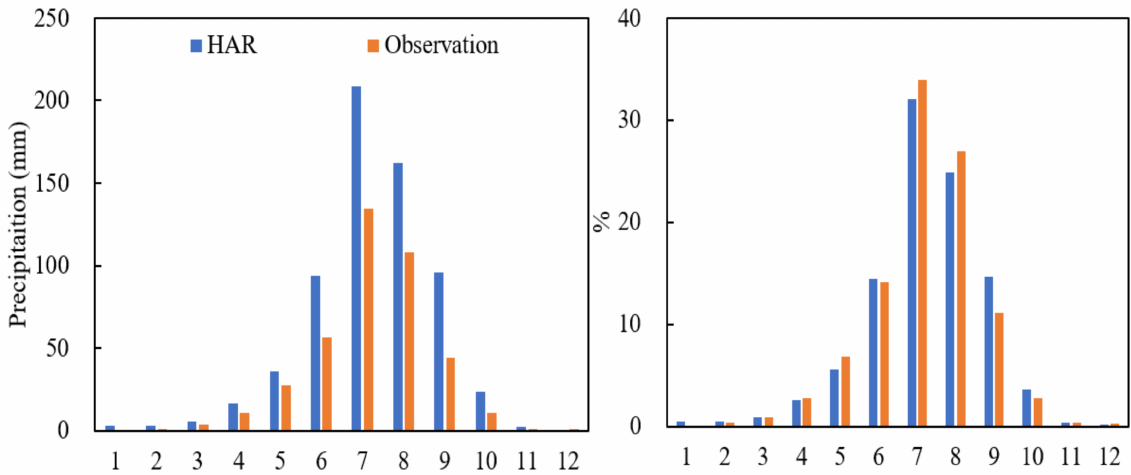
Figure 5. Comparison of annual average precipitation and seasonal distribution characteristics between HAR data and Nagarze weather station. Table 4. Comparison of observed precipitation gradient and HAR precipitation gradient. Observed Precipitation Location in the Basin Time